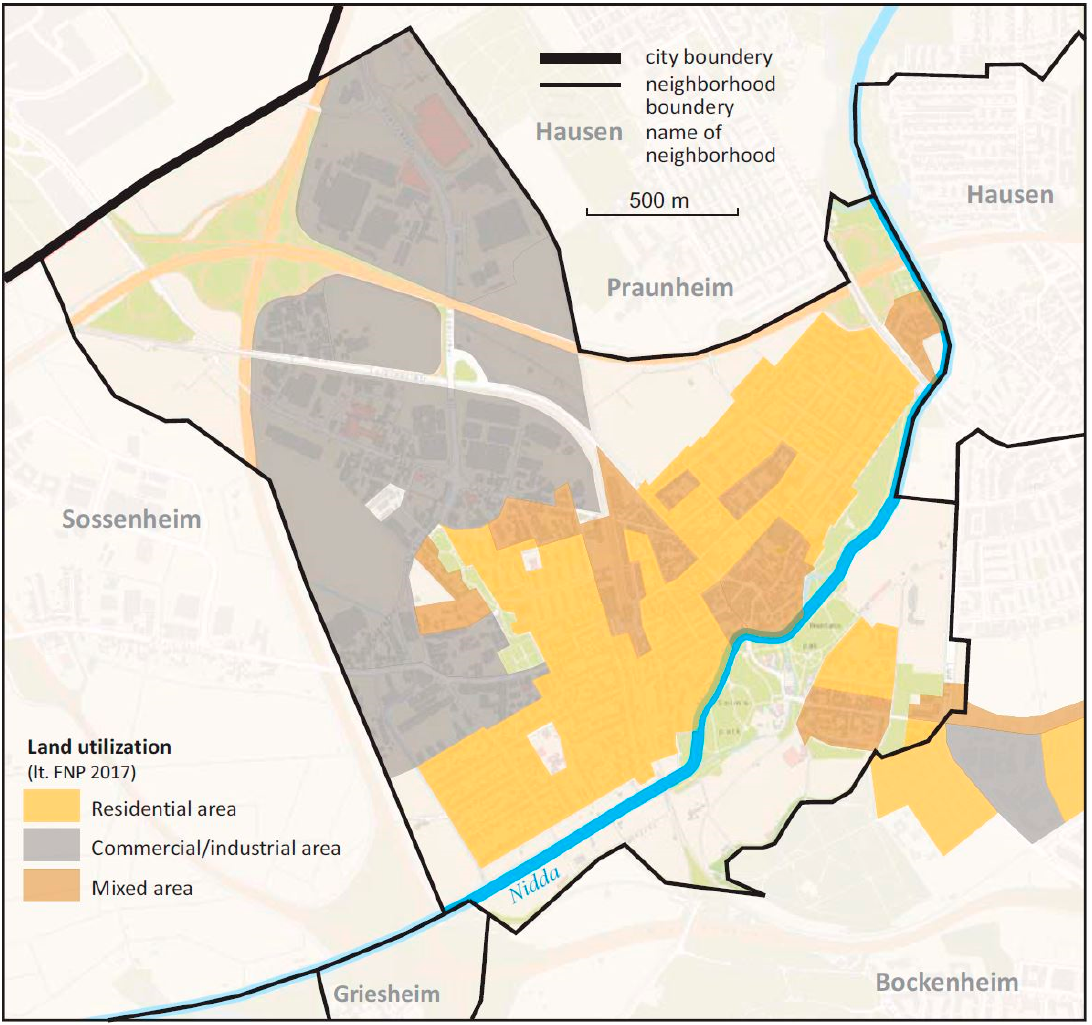
Figure 4. Map of industrial and residential areas in Rödelheim 1 (created by Department of Human Geography, Goethe-University Frankfurt, data provided by Stadt Frankfurt am Main 2019).